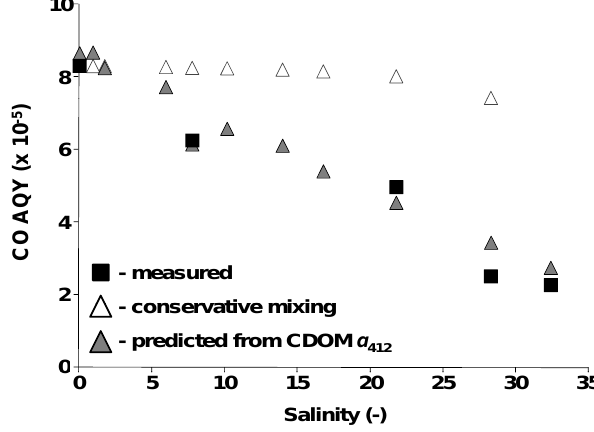
Fig. 3. Measured and modelled carbon monoxide apparent quantum yields (CO AQYs) at 325nm versus salinity in the Tyne estuary on the 9 April 2001. Grey fill squares are measured values. No fill tri- angles are values predicted based upon a conservative mixing model of the river water and marine endmembers of the Tyne estuary. Fill triangles are values predicted using in situ CDOM a 412 as a proxy for CO